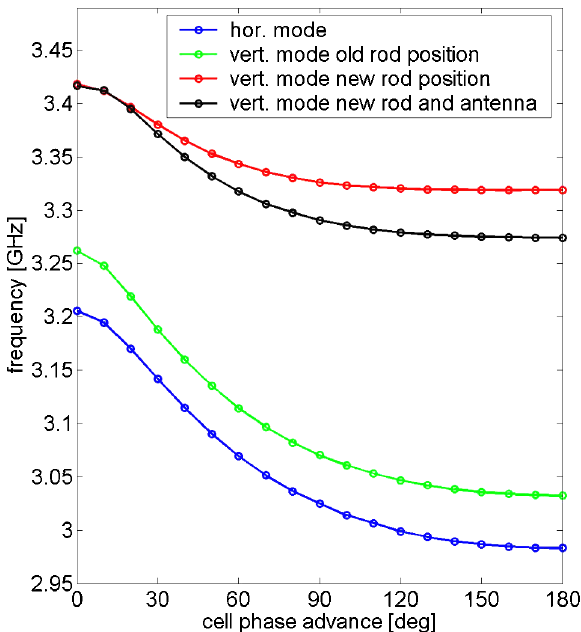
FIG. 11. Single cell geometry: (a) old; (b) rod modified; (c) rod modified and damping antenna. FIG. 12. Dispersion curves of the deflecting